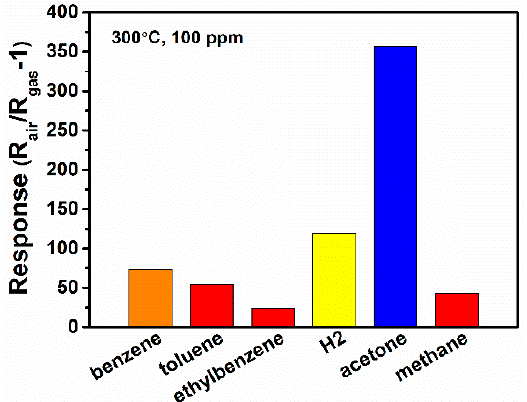
Figure 13. Cross-sensitivity toward 100 ppm of various reducing gas at 300°C of N-incorporated SnO 2 gas sensor.